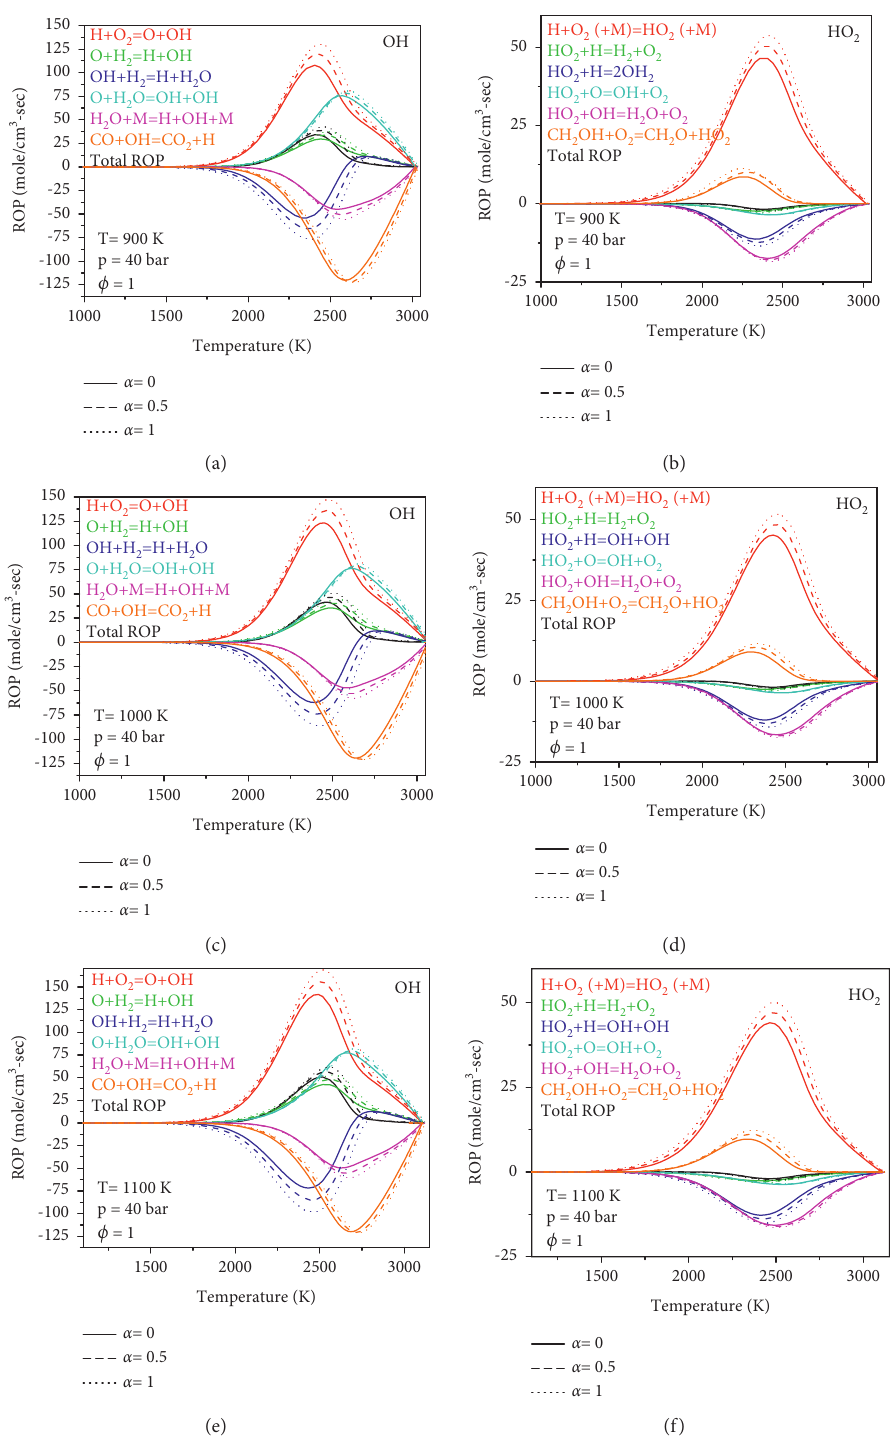
Figure 11: Rates of production and consumption of OH and HO 2 for various α values in the different temperature ranges for methane/H 2 / n-heptane mixtures at β � 4.545 × 10 − 2 , p � 40 bar, and ϕ �